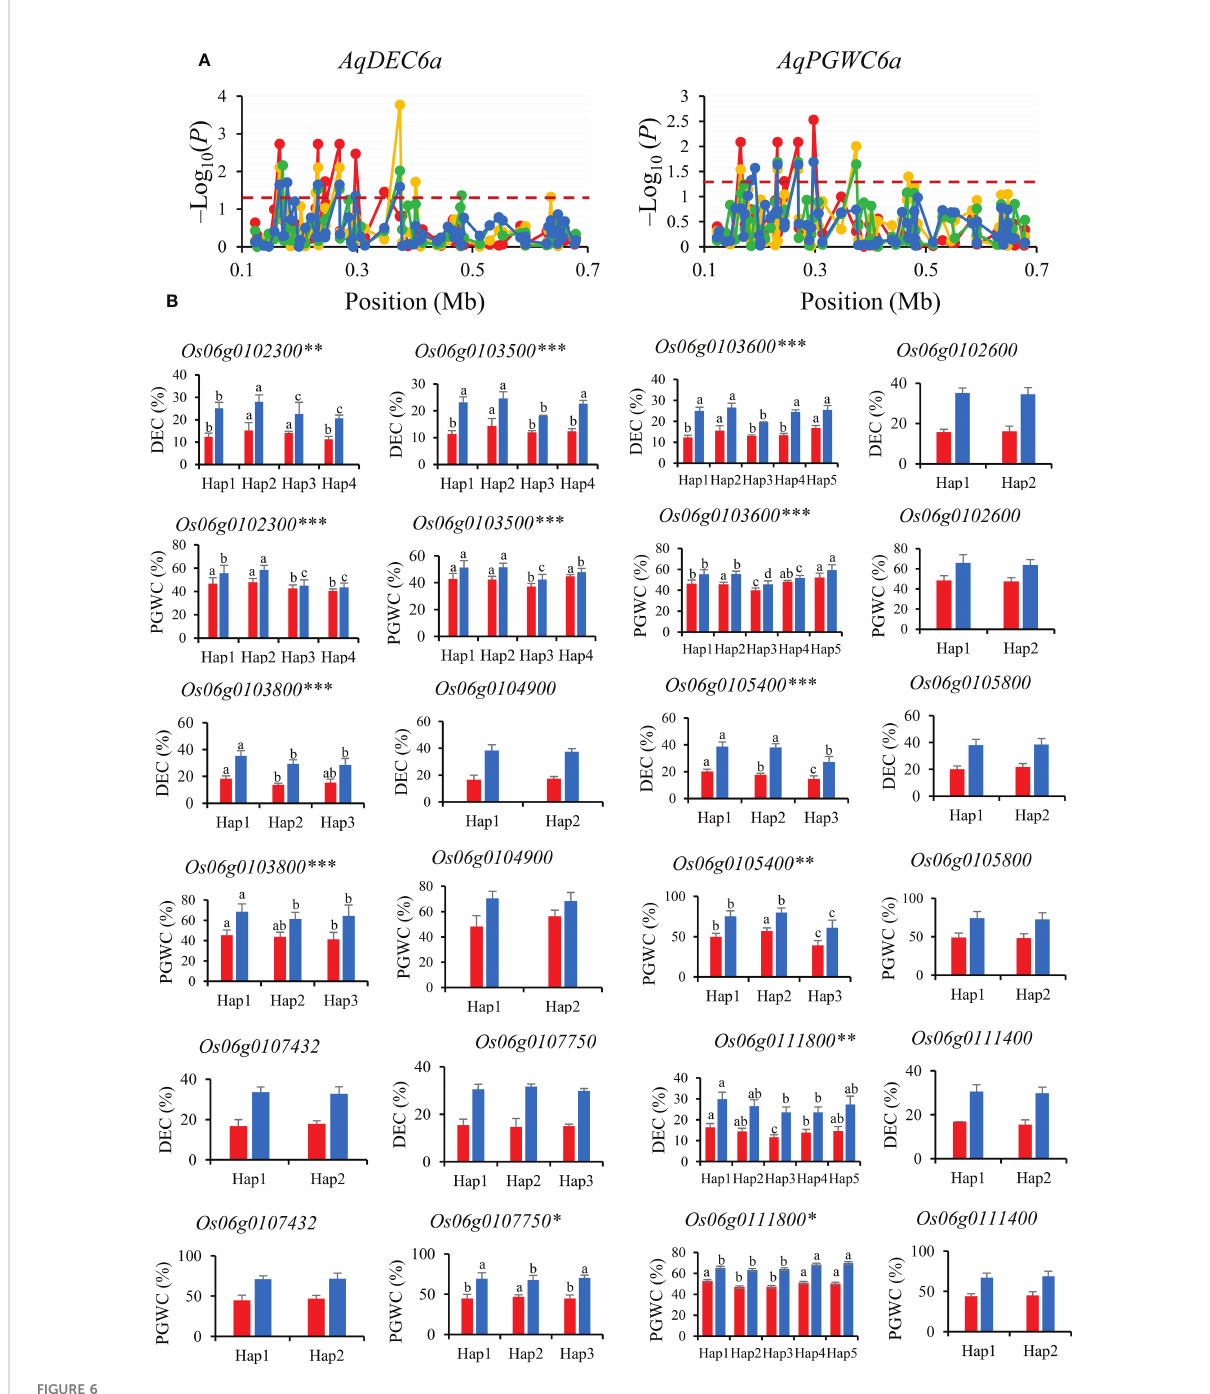
FIGURE 6 Gene-based association analysis (A) and haplotypes analysis of candidate genes (B) of AqDEC6a/AqPGWC6a. Dash line showed the threshold to determine signi fi cant SNP. The *, ** and *** suggested signi fi cance of ANOVA at p < 0.05, p < 0.01 and p < 0.001, respectively. The letter on histogram (A – D) indicated multiple comparisons result at the signi fi cant level 0.05. Red, orange, green and blue color of lines indicated 15_PX, 16_PX, 15_SZ and 16_SZ environments, respectively. The red and blue color of the histogram indicated SY and SZ in 2015,